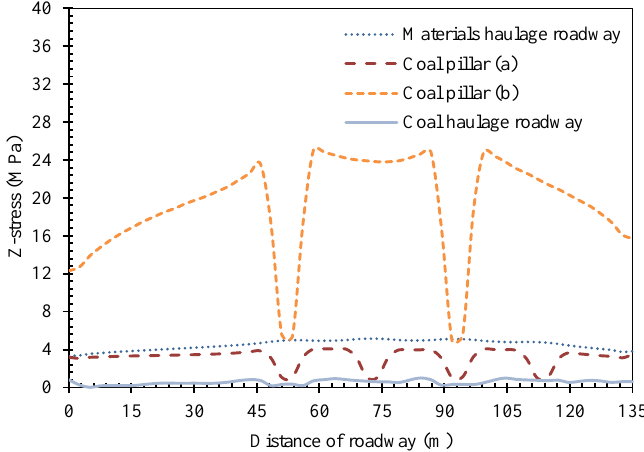
Figure 15. Stress evolution for monitoring points.